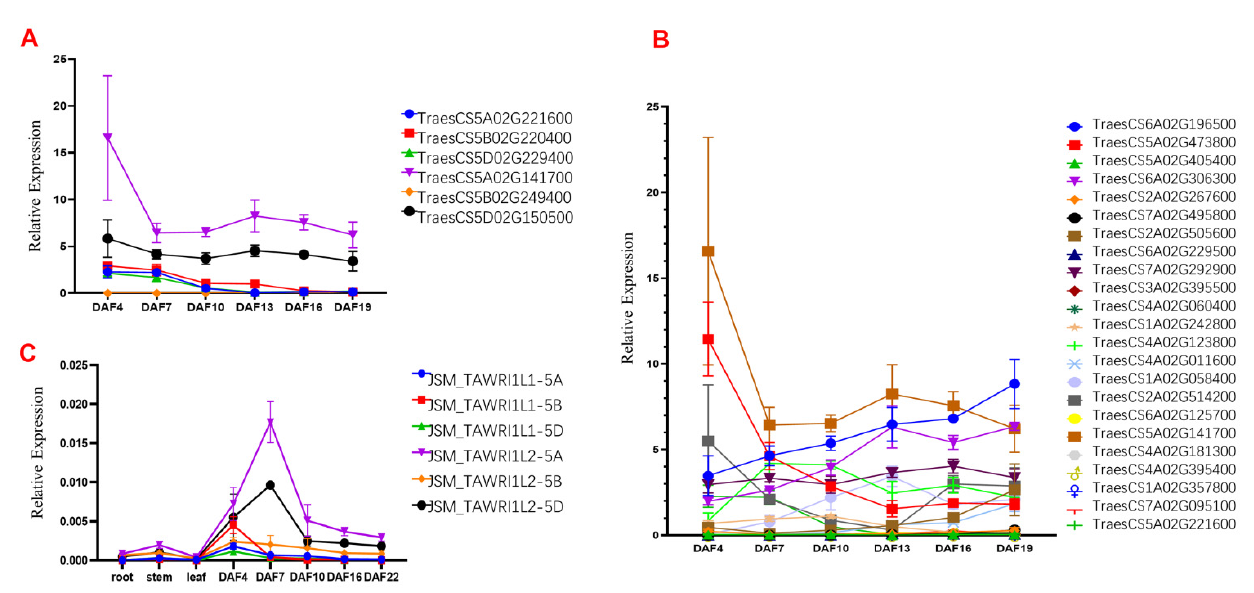
Figure 2. Expression levels of TaWRI1Ls and their paralogs in Chinese Spring and Fielder. ( A ) TaWRI1Ls of Chinese Spring grains at different filling stages; ( B ) the 21 paralogs of Chinese Spring grains at different filling stages; ( C ) TaWRI1Ls of Fielder root, stem, leaf, and grain at different filling. Bars represent the means ± SD of three biological